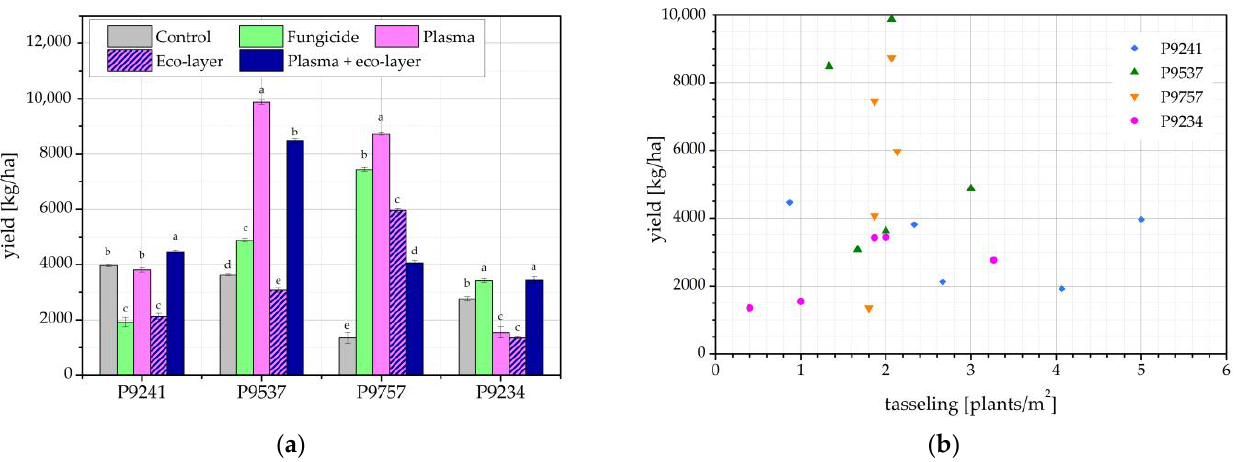
Figure 5. ( a ) Maize yield; and ( b ) correlation between number of plants at tasseling time and maize yield in the harvest year 2020. The error bars represent standard error. Different lowercase letters above data points represent statistically significant differences ( p < 0.05; post hoc Tukey’s range test) between treatments.